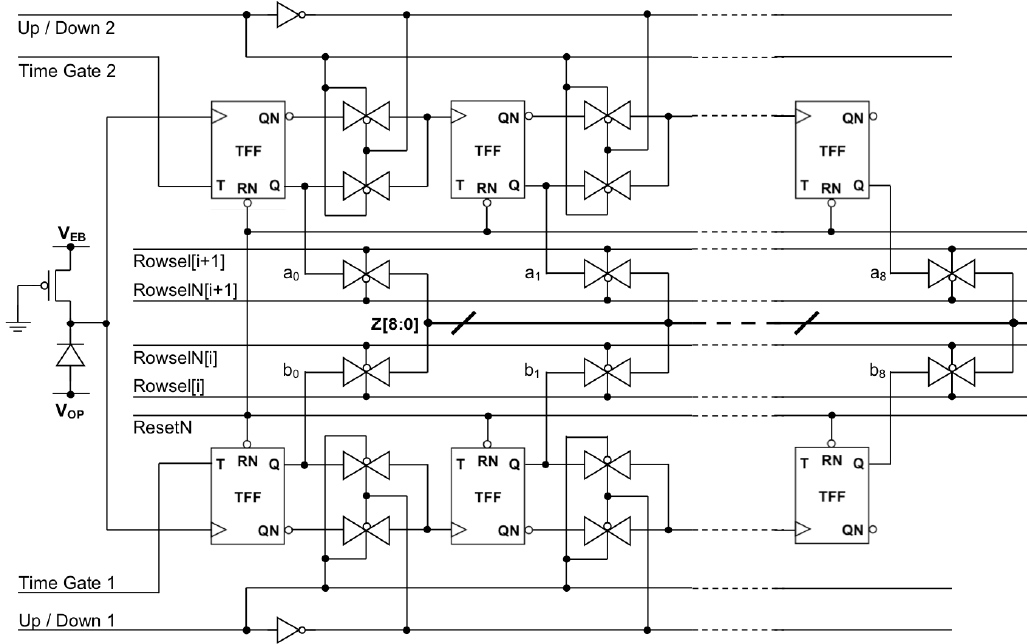
Figure 9. SPAD circuit with passive quench transistor and two associated 9-bit ripple